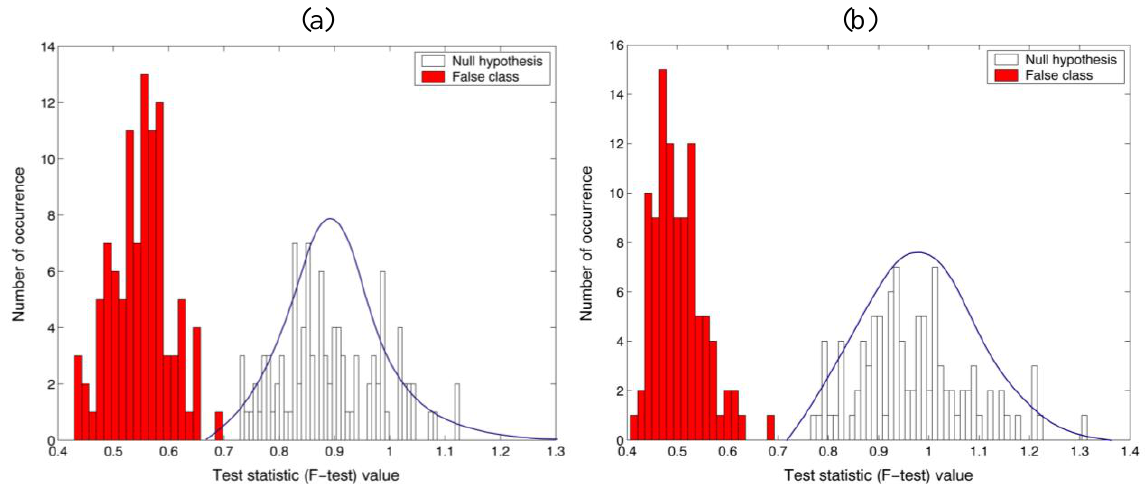
Figure 4. Parametric F-test results for the equality of two variances. 200 test pixel points were selected from segmented holographic image. (a) real part and (b) imaginary part in the reconstructed image. Reference: Oscillatoria bacteria. False class: Diatom